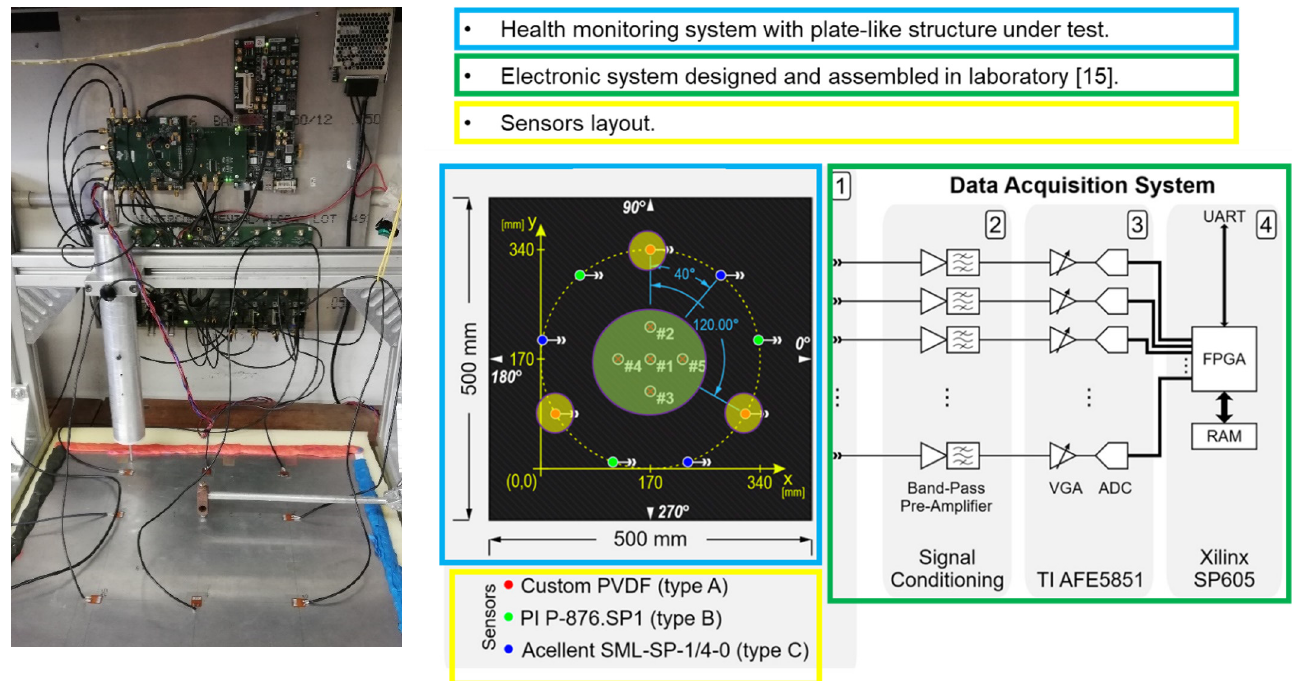
Figure 6. Experimental set-up with the eight piezoceramic transducers attached with a bi-adhesive tape to a 1.4 mm aluminum plate, shown in the bottom of the figure, and the real-time electronic acquisition system, shown in the top. In the center of the plate, the low-energy hammer impactor is visible. The figure also shows the colored play dough covering the edges of the aluminum plate; this method was adopted to attenuate the signals received from multipath. Reproduced from [24].